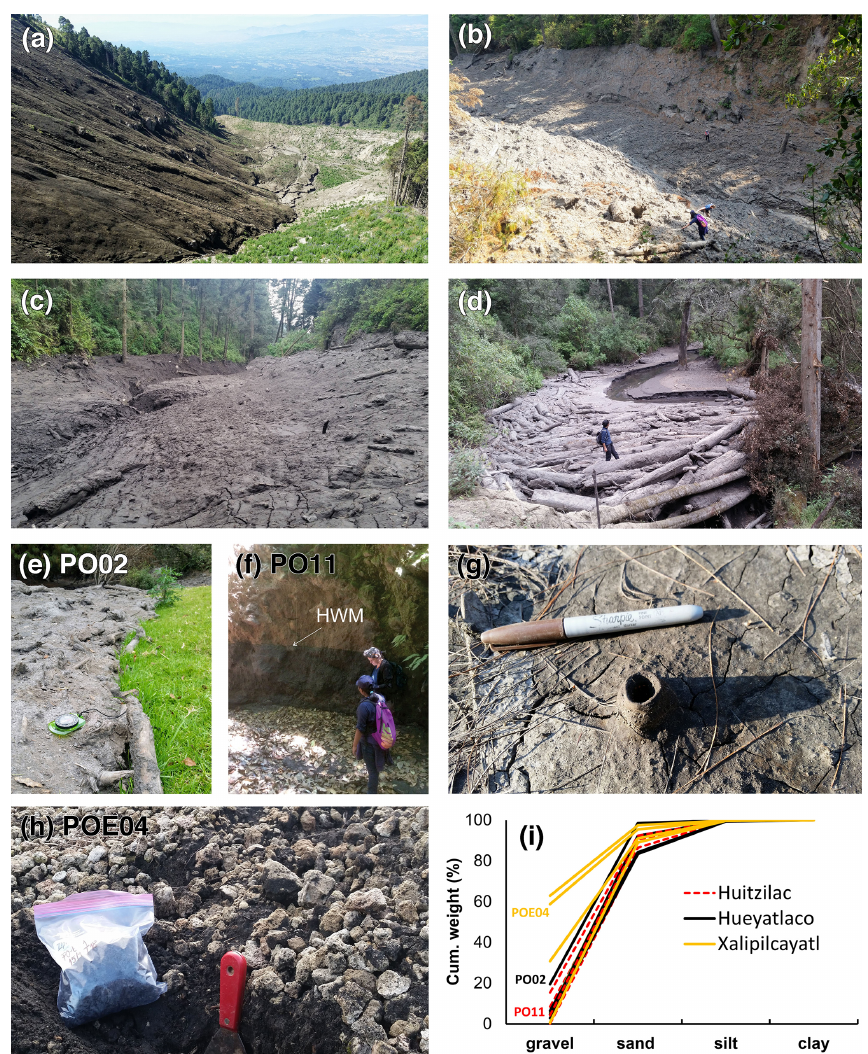
Figure 8. Debris-flow deposits in the upper (a–c) , intermediate (d–f) , and lower reaches (g–h) of the Huitzilac, Hueyatlaco, and Xalipilcayatl basins: (a) scarp of landslide A-1 at Huitzilac (view from point PO06), (b) main channel of the Huitzilac ravine (PO17), (c) main channel of the Hueyatlaco ravine (PO1701), (d) large wood deposits at Hueyatlaco (PO03), (e) overbank deposits at Hueyatlaco (PO02), (f) mud trace on lateral terraces at Huitzilac (HWM: height of watermark) (PO11), (g) evidence of dewatering at Huitzilac (PO19), (h) detail of the lower deposit at Xalipilcayatl (POE04), and (i) grain size distribution of the samples of the